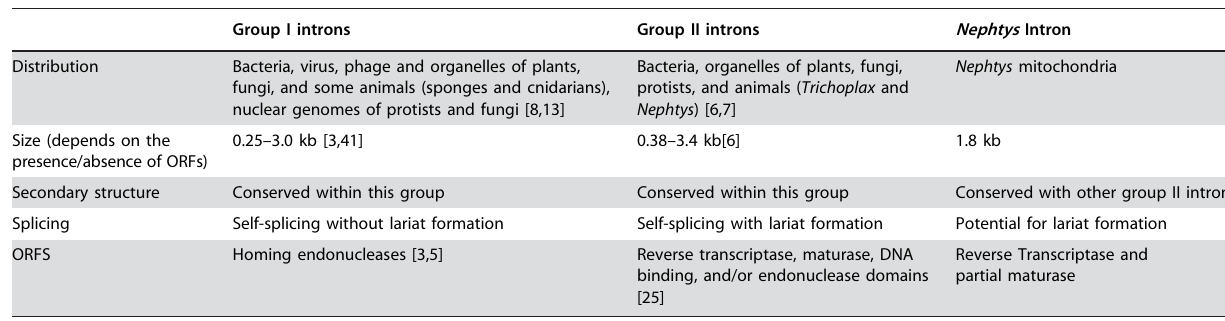
Table 1. Key characteristics of group I and group II self-splicing introns. .. ... .... ... ... .... ... ... .... ... ... .... ... ... .... ... ... .... ... ... .... ... ... .... ... ... .... ... ... .... ... ... .... ... ... .... ... ... .... ... ... .... ... ...